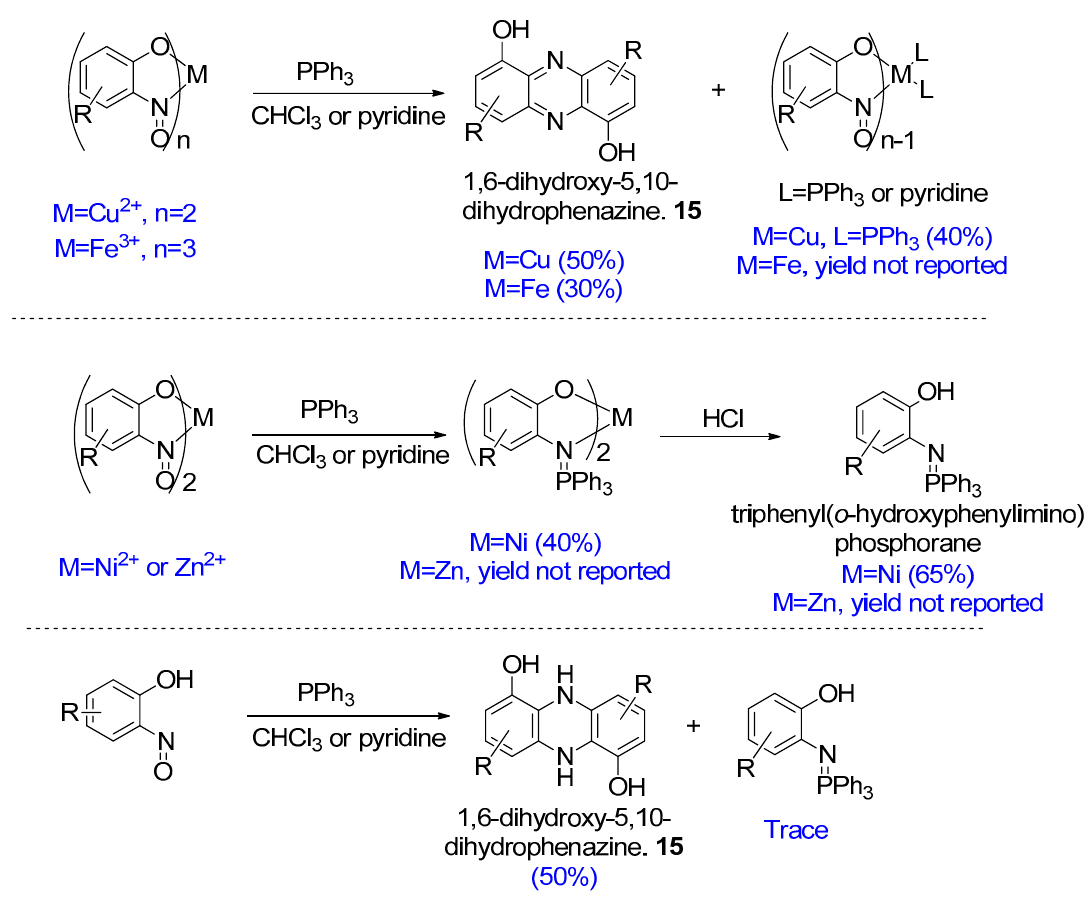
Figure 12. Reactions reported by Charalambous et al. [77].